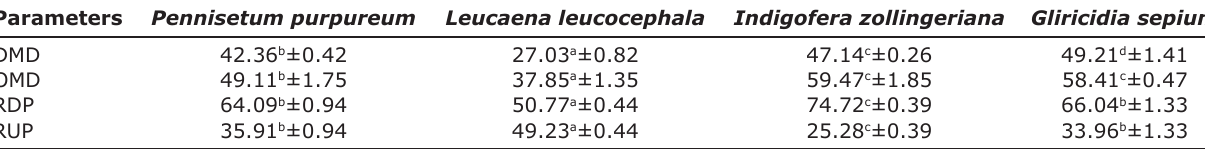
Table-4: Dry matter digestibility, organic matter digestibility, RDP content, and RUP content of concentrates (%). Parameters